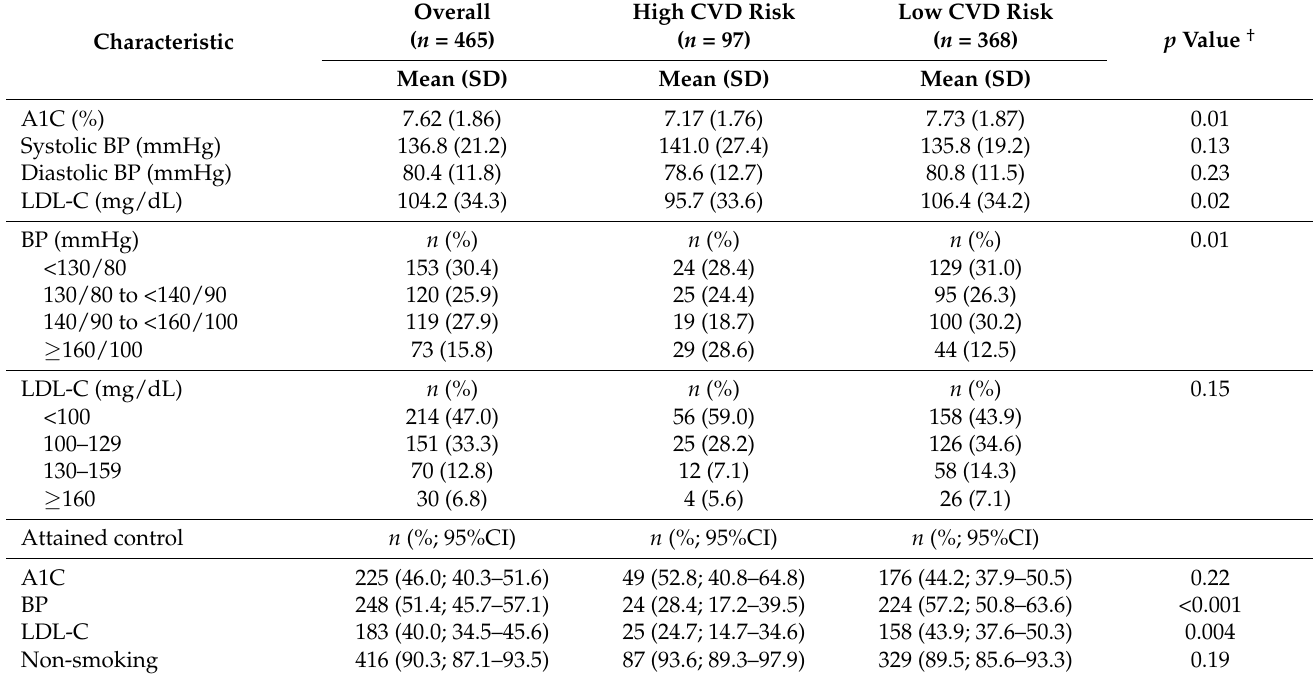
Table 2. Levels of glycated hemoglobin (A1C), blood pressure (BP), and low-density lipoprotein-cholesterol (LDL-C), distribution of blood pressure and LDL-C categories, and percent reaching the target value (“in control”) of each among individuals with self-reported diabetes: Laboratory subsample, National Health Survey—Brazil,